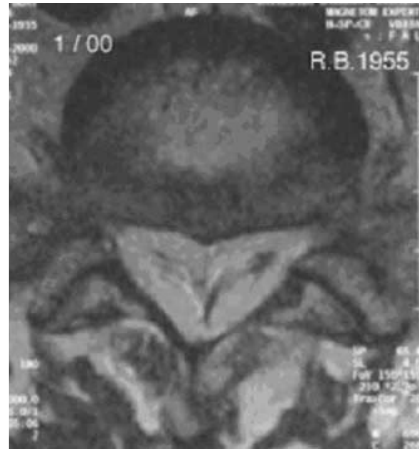
Patient 1: MRI of the lumbar spine reveals the typical stellate configuration of the caudal dural